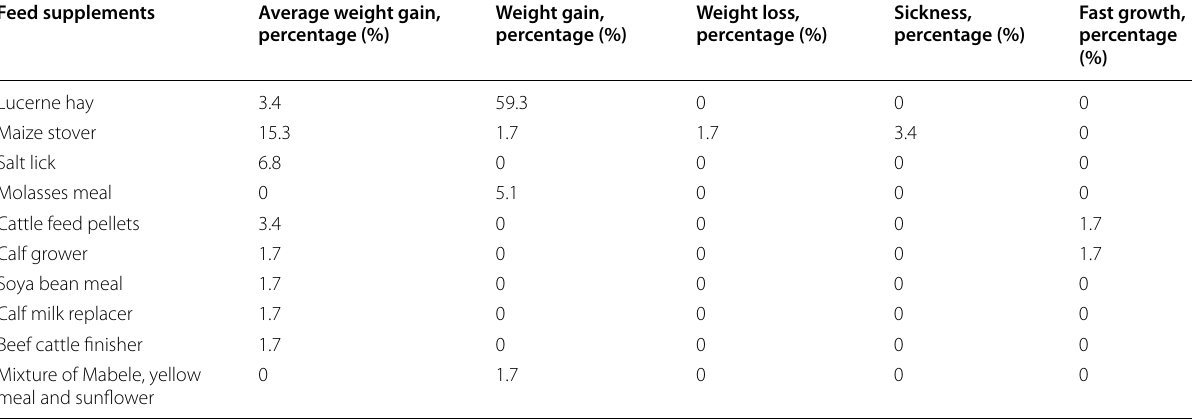
Table 5 The farmers’ reasons for acceptability of feed supplements for cattle in communal areas of Limpopo province Feed